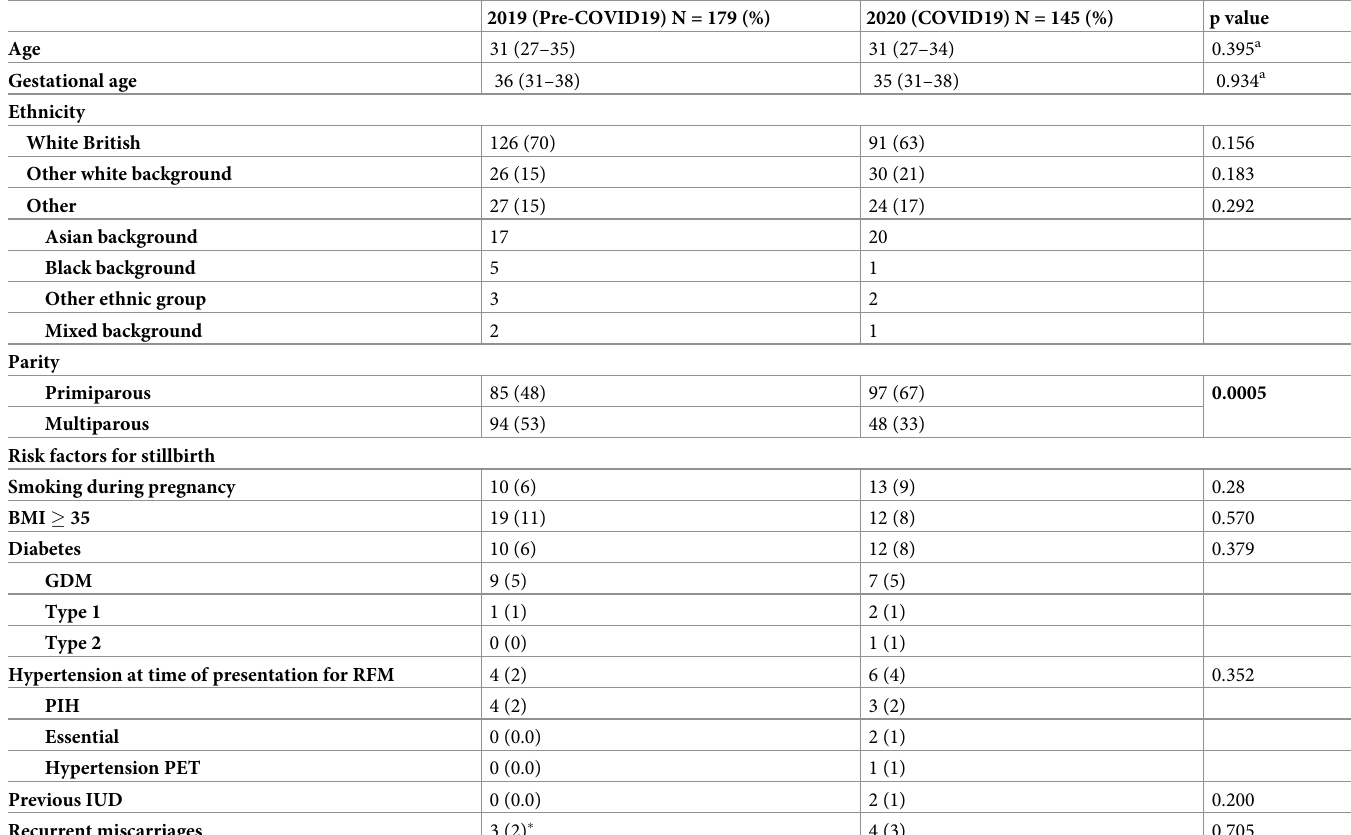
Table 1. Patient characteristics.